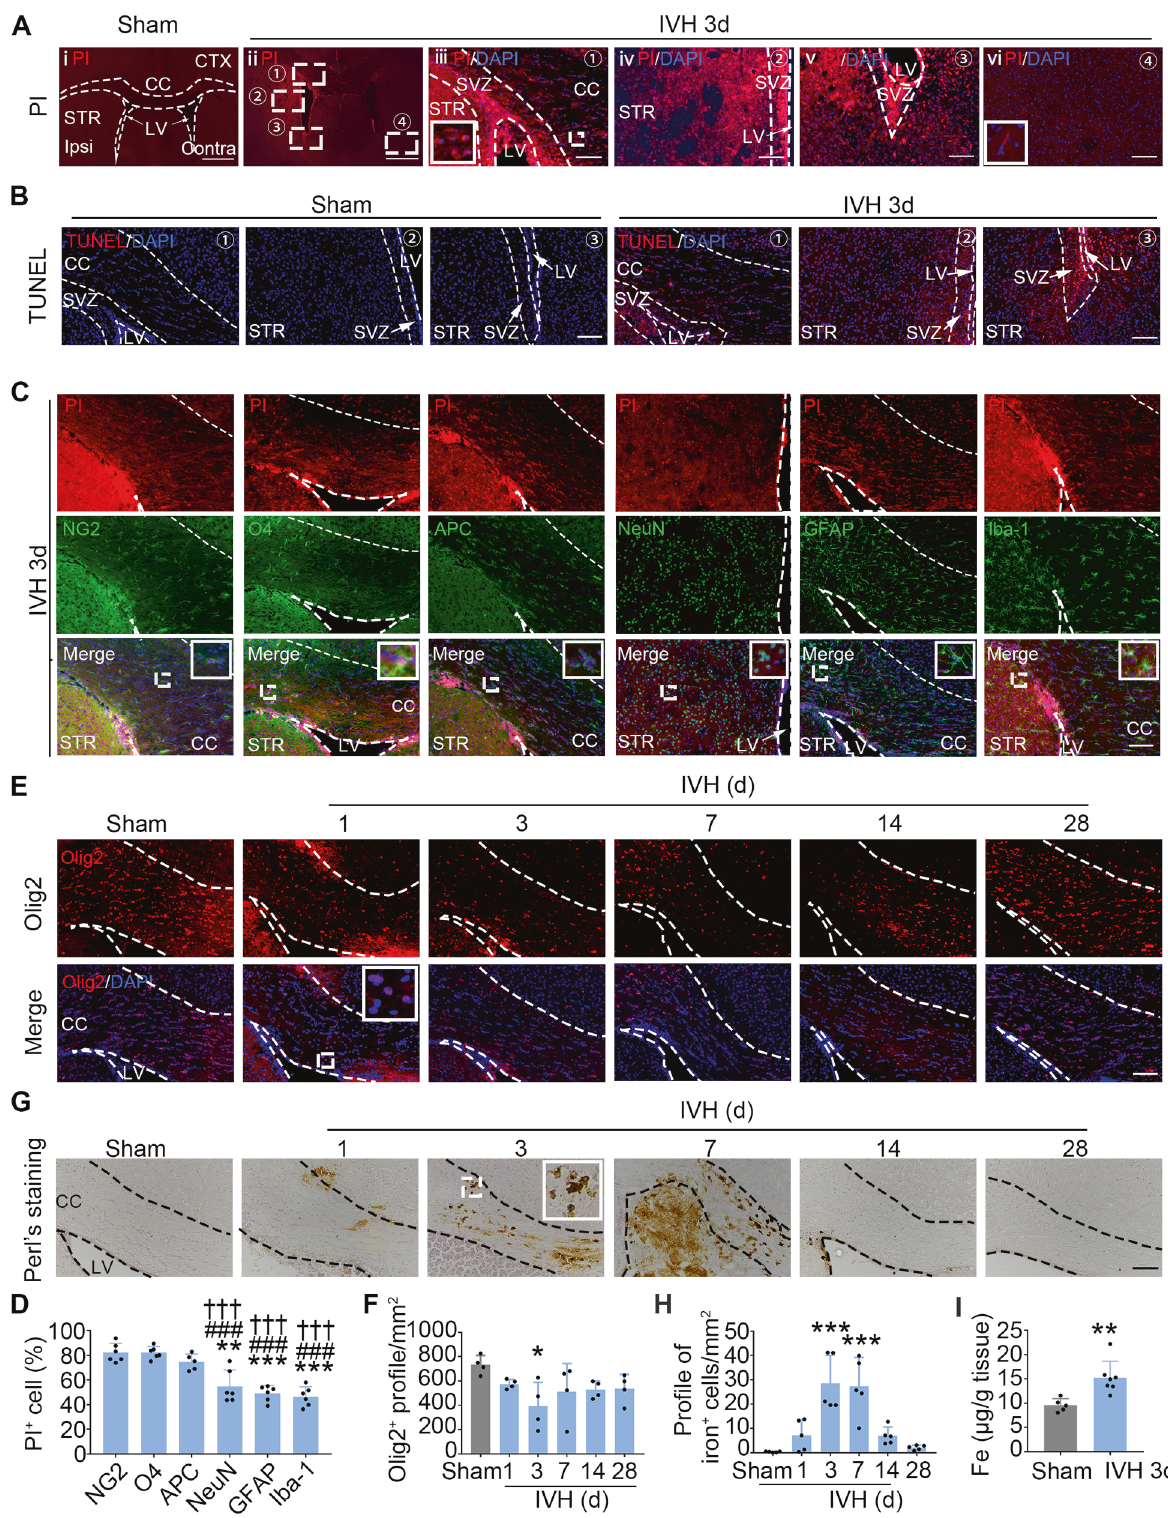
RNA-seq data (Fig. s2C). The gene ontology (GO) enrichment was analyzed and the network plot revealed the relationships between the main regulated biological processes ( p < 0.05 and fold change > 3), which were related to ferroptosis, spinal cord injury, and cell migration (Fig. 3E). The Kyoto Encyclopedia of Genes and